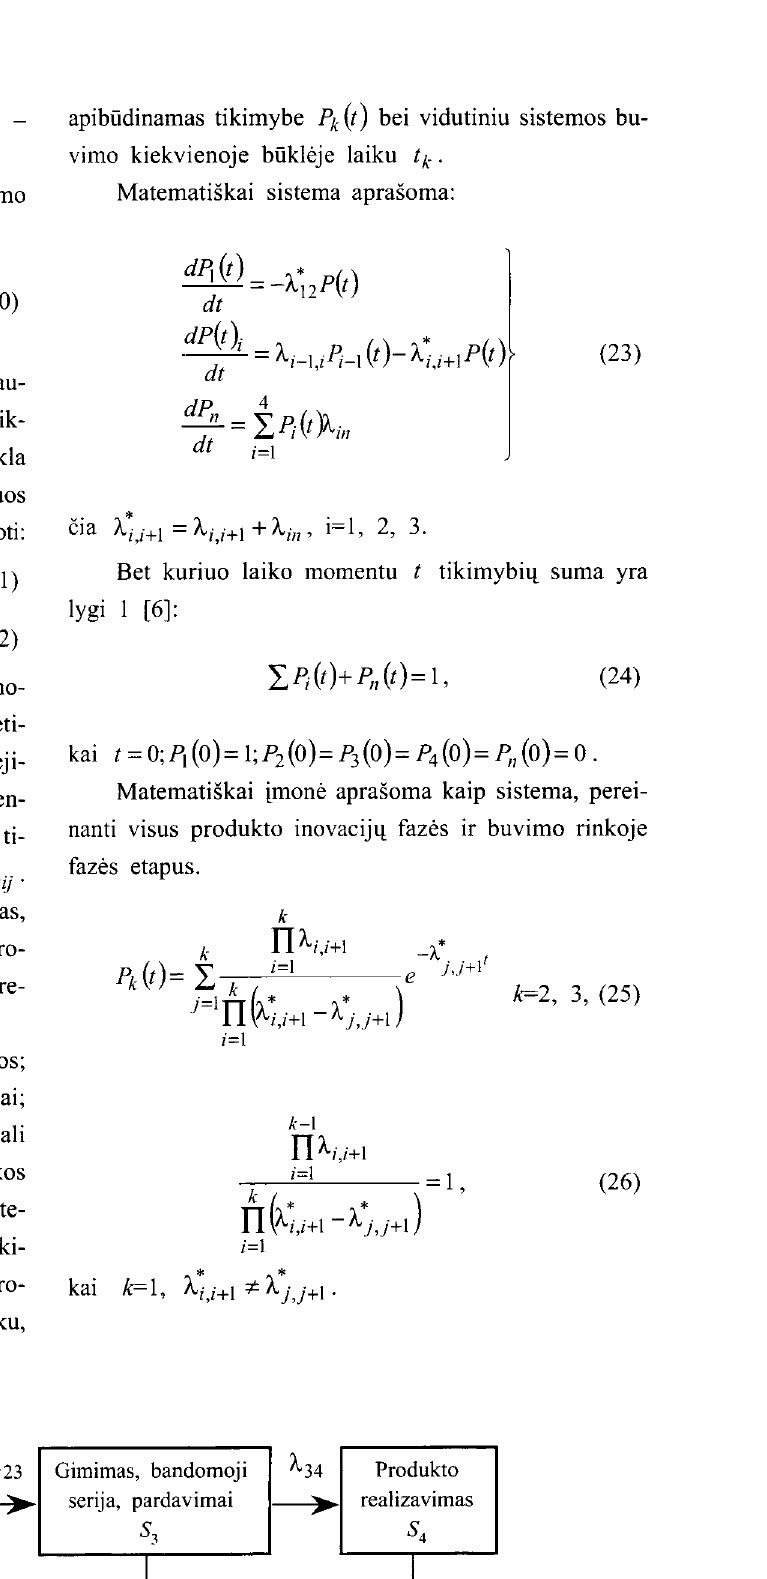
Fig 2. Stochastic model of product life cycle